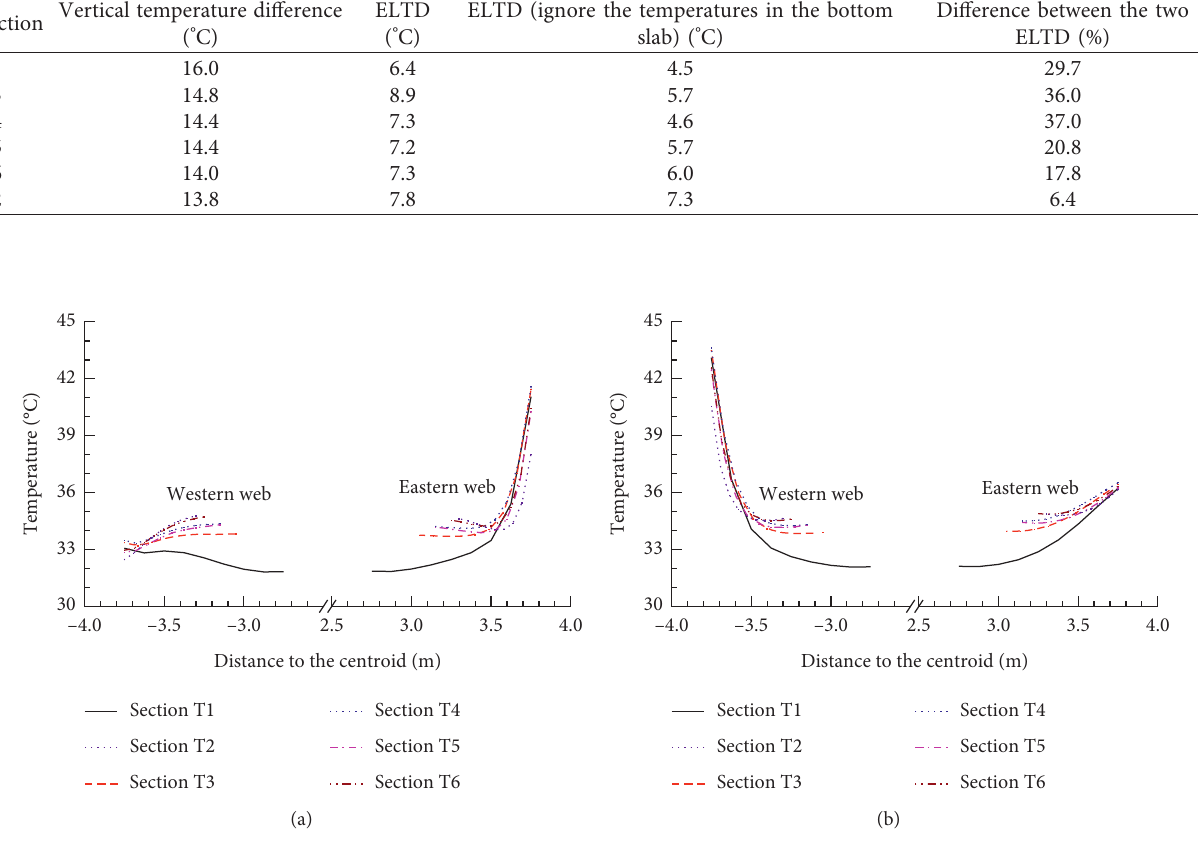
Figure 16: The predicted transverse temperature distributions along the web of the girder at the six cross-sections on August 3, 2010, when the temperatures on the outer surface of the web reached a maximum value: (a) eastern web; (b) western